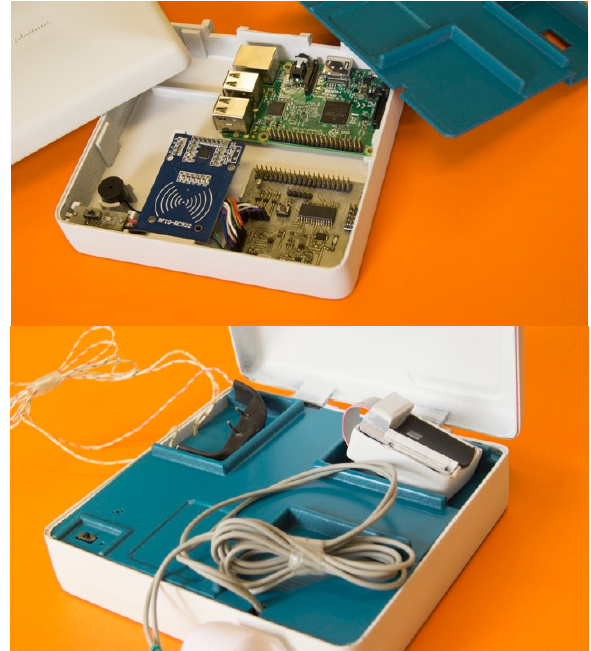
Figure 7. PlaIMoS fixed measurement station opened.